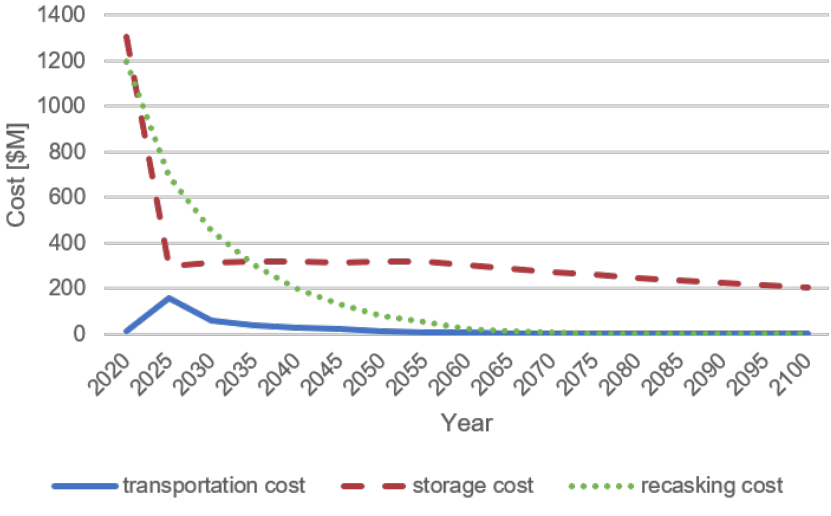
Figure 4. Distribution of costs over time in the business as usual (BAU) scenario. Source: own